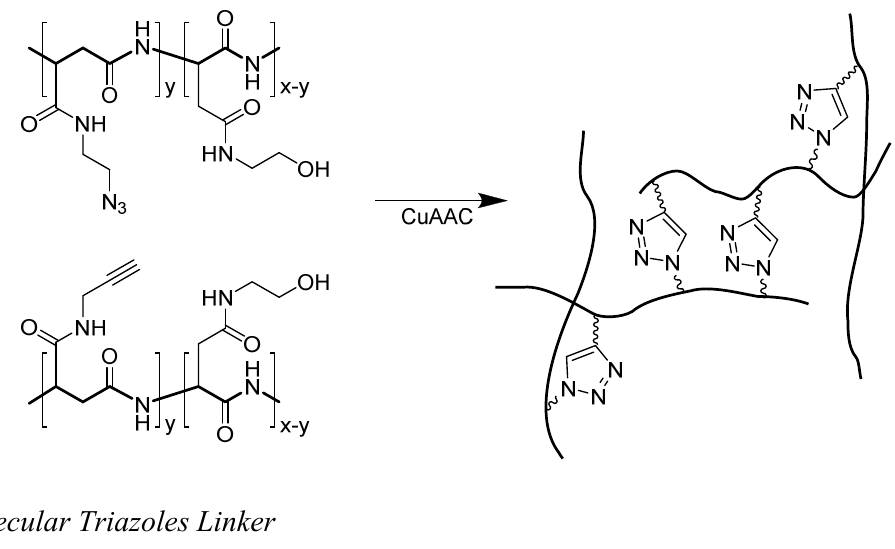
Figure 13. Formation of hydrogel based on multilinker conjugation via